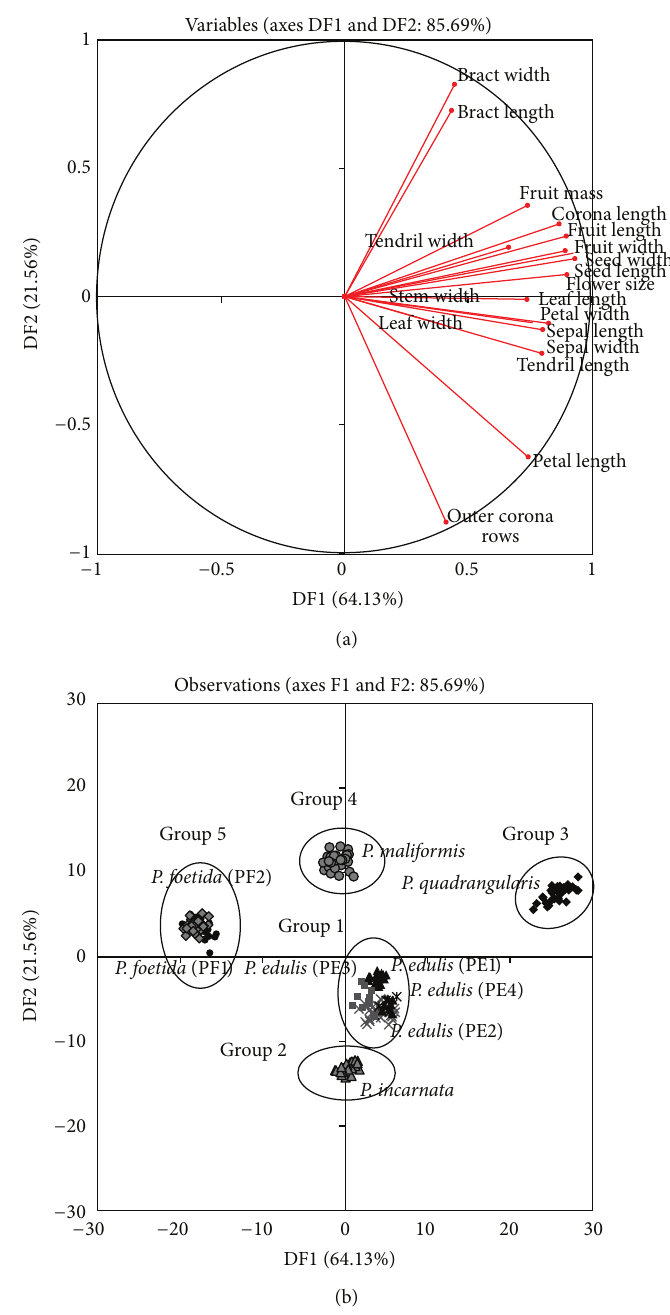
Figure 1: (a) Plot of the morphological parameters of the Passiflora accessions. Percentages in parentheses represent the variation in each component. (b) Positions of the DF scores of nine Passiflora accessions relative to DF1 and